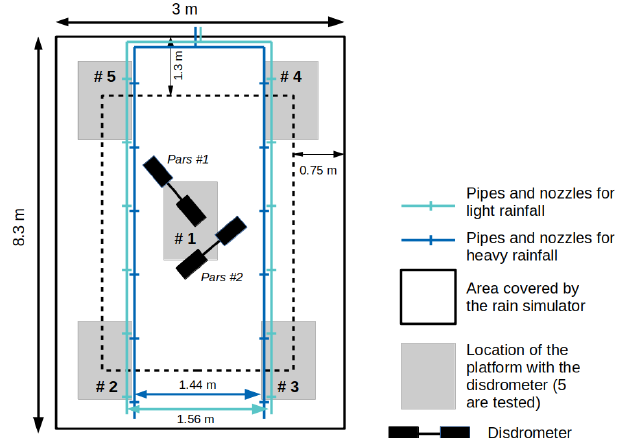
Figure 2. Scheme of the various locations tested over the area cov- ered by the rainfall